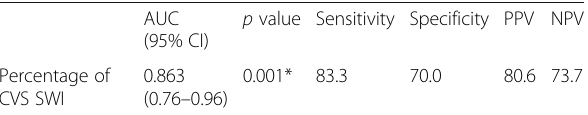
Table 4 The sensitivity, specificity, PPV, NPV and AUC for central vein sign in MS patients